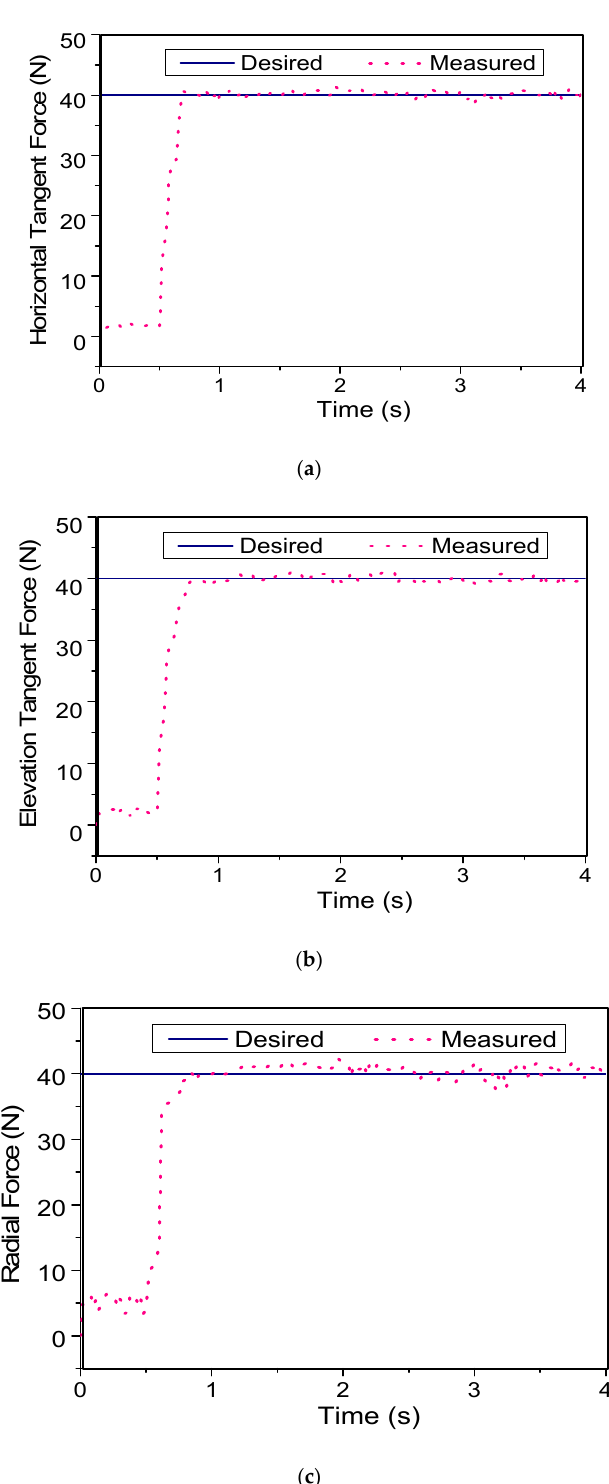
Figure 22. Experimental results on the step response of the force feedback system. ( a ) Horizontal force reflection. ( b ) Elevation force reflection. ( c ) Radial force reflection.